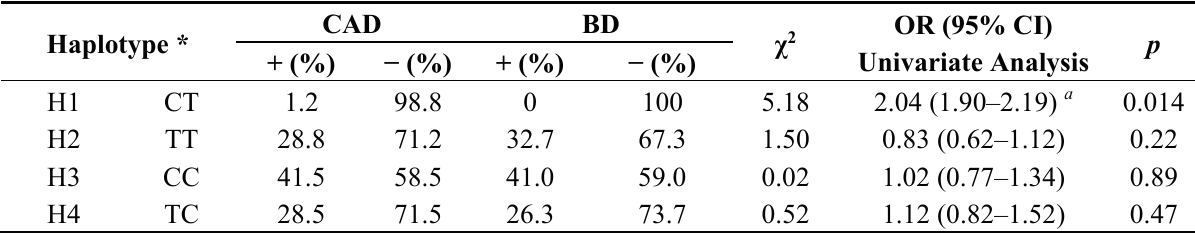
Table 3. Association of the USF1 gene haplotypes with coronary artery disease. Haplotype